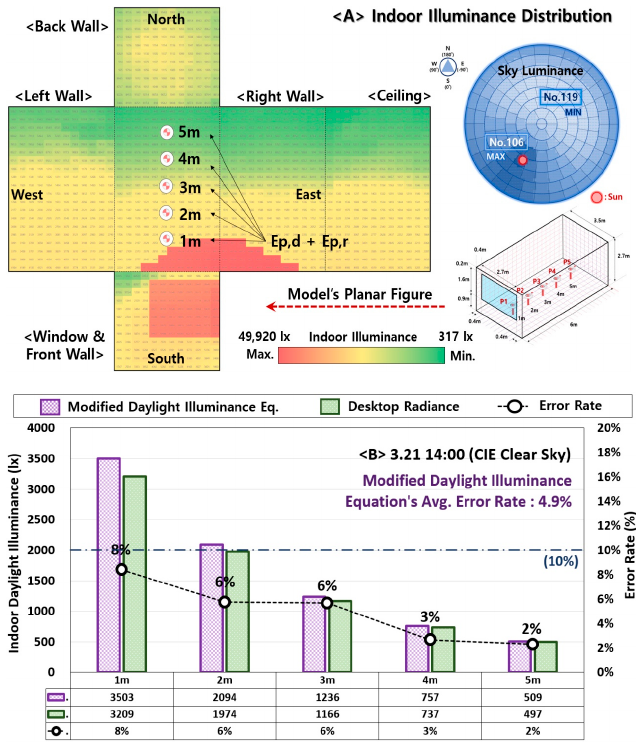
Figure 14. Indoor illuminance distribution of the six–side planar figure and comparison of illuminance between the modified equation and Desktop Radiance (CIE Clear Sky_3.21 14:00).